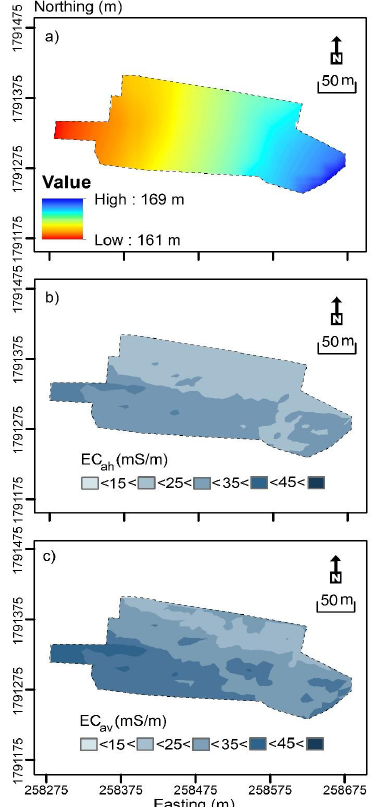
Figure 3. Contour plot of ( a ) elevation (m), and apparent electrical conductivity (EC a – mS / m) of EM38 measured in ( b ) horizontal (EC ah ; 0–0.75 m), and ( c ) vertical (EC av ; 0–1.5 m) modes.